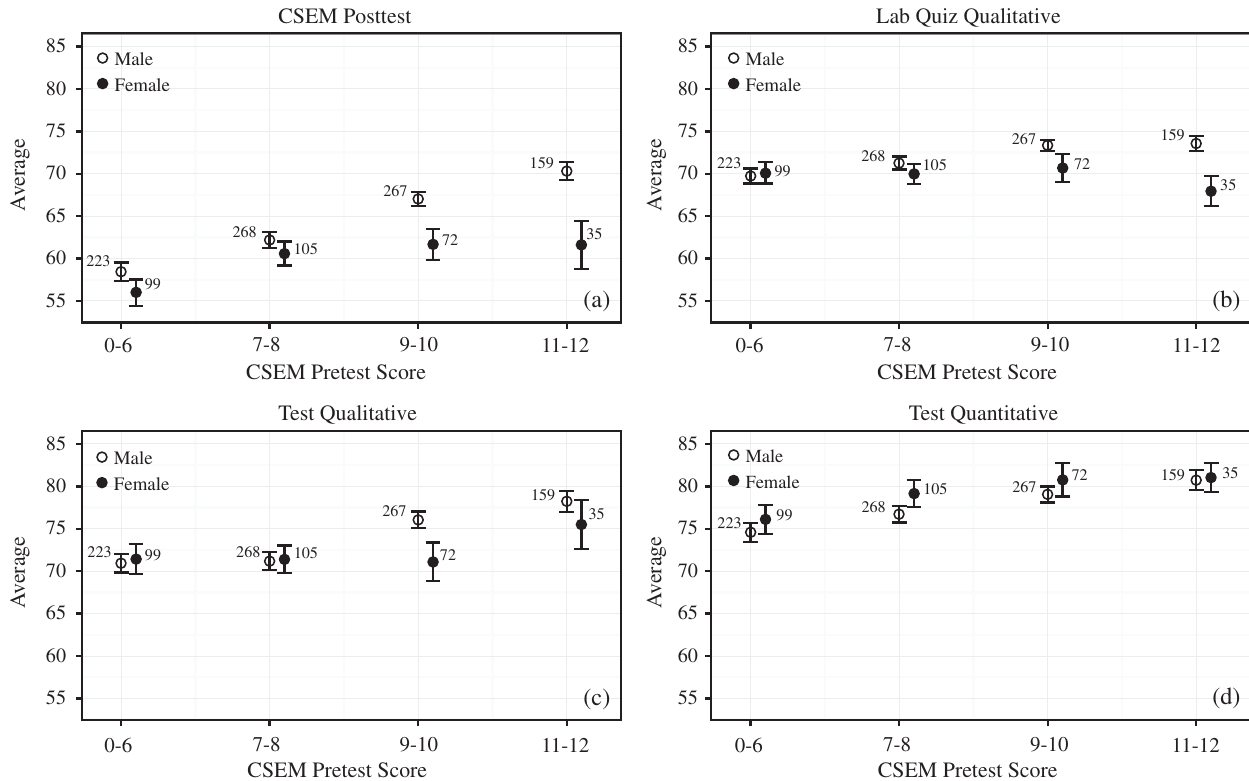
FIG. 3. Evaluation average vs CSEM pretest: (a) the CSEM post-test, (b) qualitative lab quiz problems, (c) qualitative test problems, and (d) the quantitative test problems. Female averages were shifted to the right to increase readability. The number printed next to the point is the number of students within each pretest